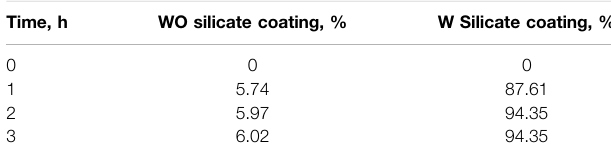
TABLE 6 | Results of the antibacterial ef fi ciency in air of the WO and W silicate coatings. Time, h WO silicate coating, % W Silicate coating, %